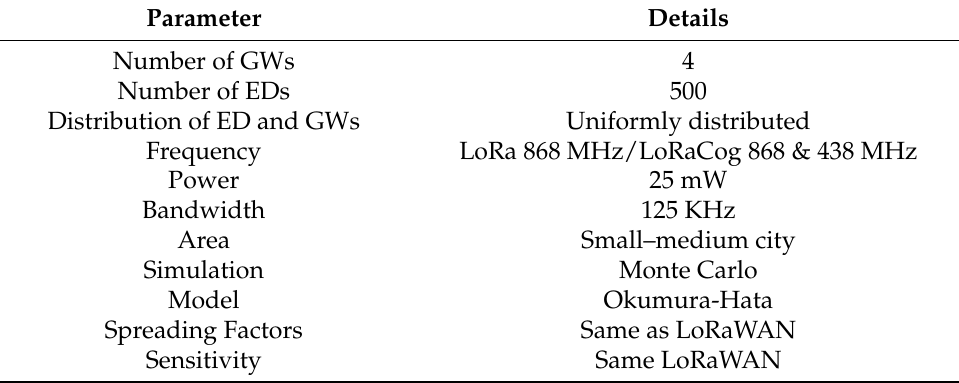
Figure 8. Representation of the EDs and the GWs distribution in our simulations. Table 1. Matlab Simulations